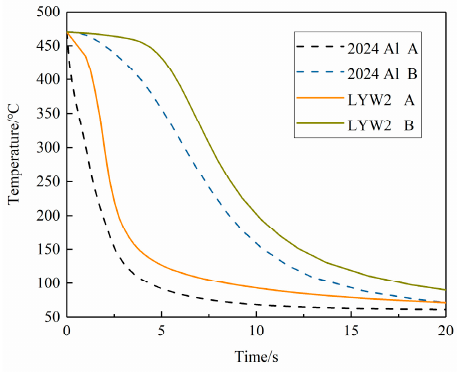
Figure 19. Cooling curves of 2024Al and W / 2024Al block; A denotes the point with the lowest temperature; B denotes the point with the highest temperature during quenching process.